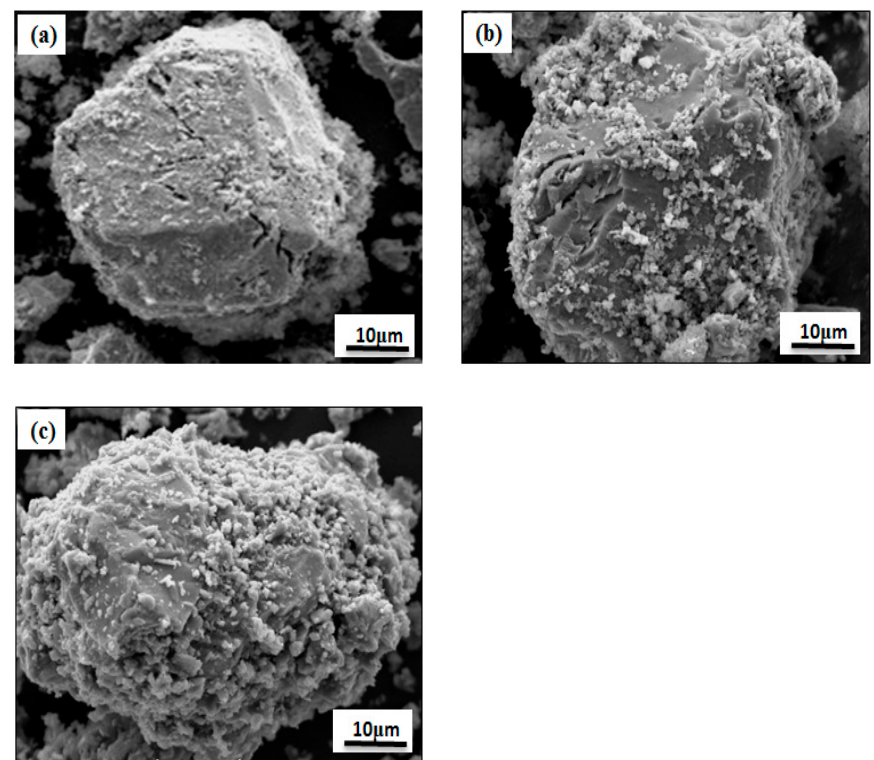
Figure 8. The morphologies of leaching residue after ( a ) 10 days, ( b ) 20 days, and ( c ) 30 days in the bacteria–mineral noncontact leaching system (SE). 3.4.3. FTIR Analysis of Leaching Residue Figure 9 shows the FTIR spectra of both kinds of leaching residue after leaching for 30 days. The adsorption peaks at 515 and 474 cm − 1 were attributed to the stretching vibra- tion of the FeO 6 octahedron [35], that at 630 cm − 1 was attributed to the υ 4 stretching vibra- tion of SO 42 − , that at 1020 cm − 1 was attributed to the γ 1 bending vibration of SO 42 − , those at 1090 and 1193 cm − 1 were attributed to the γ 3 bending vibration of SO 42 − [36], that at 1663